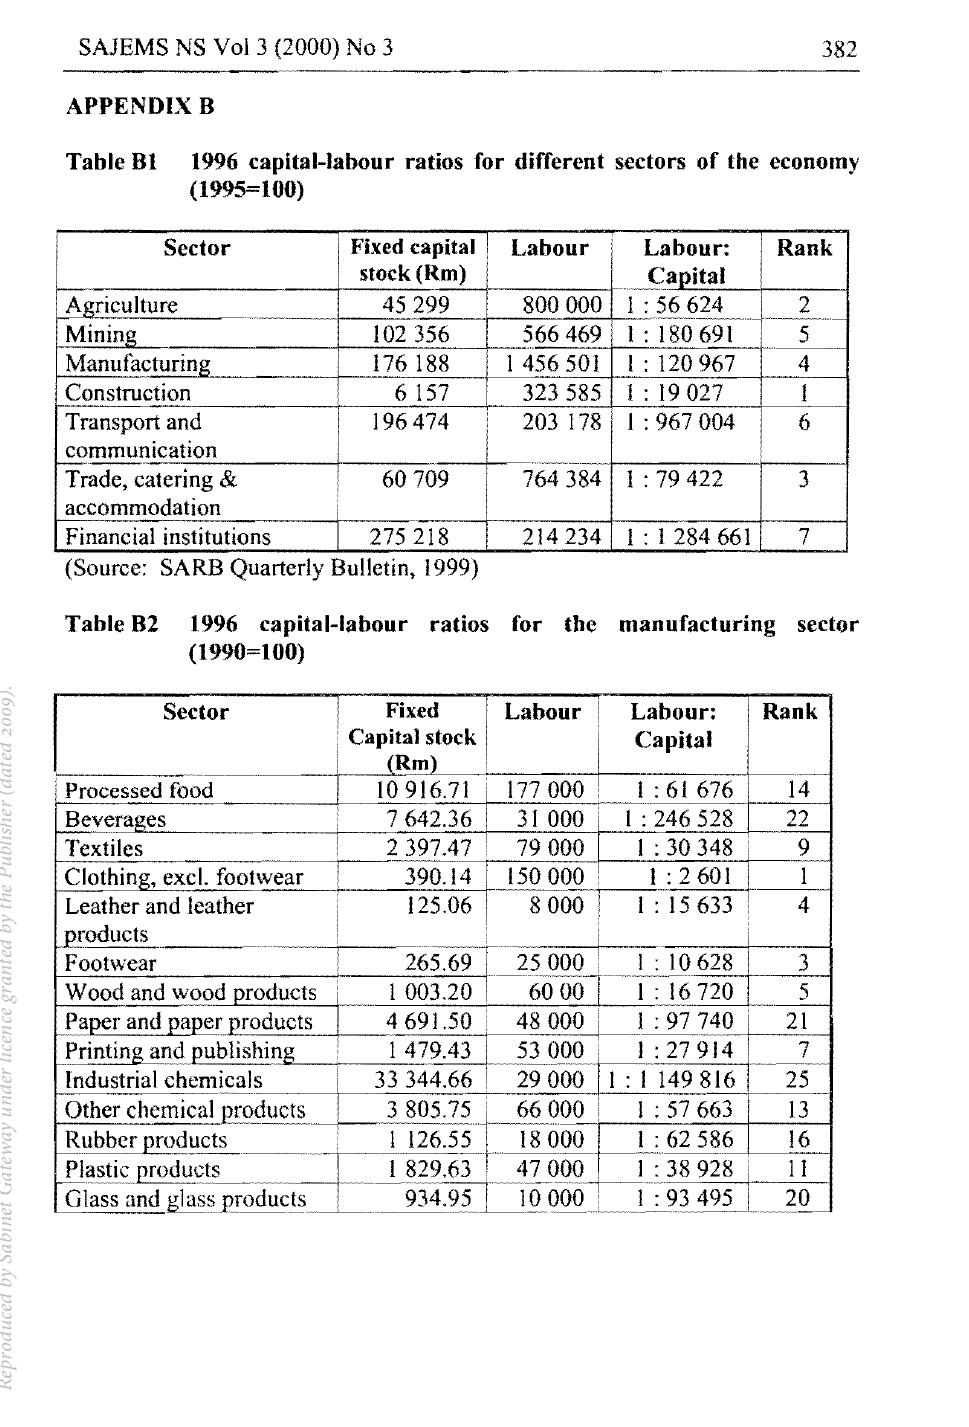
1996 capital-labour ratios for different sectors of the economy (1995=100)